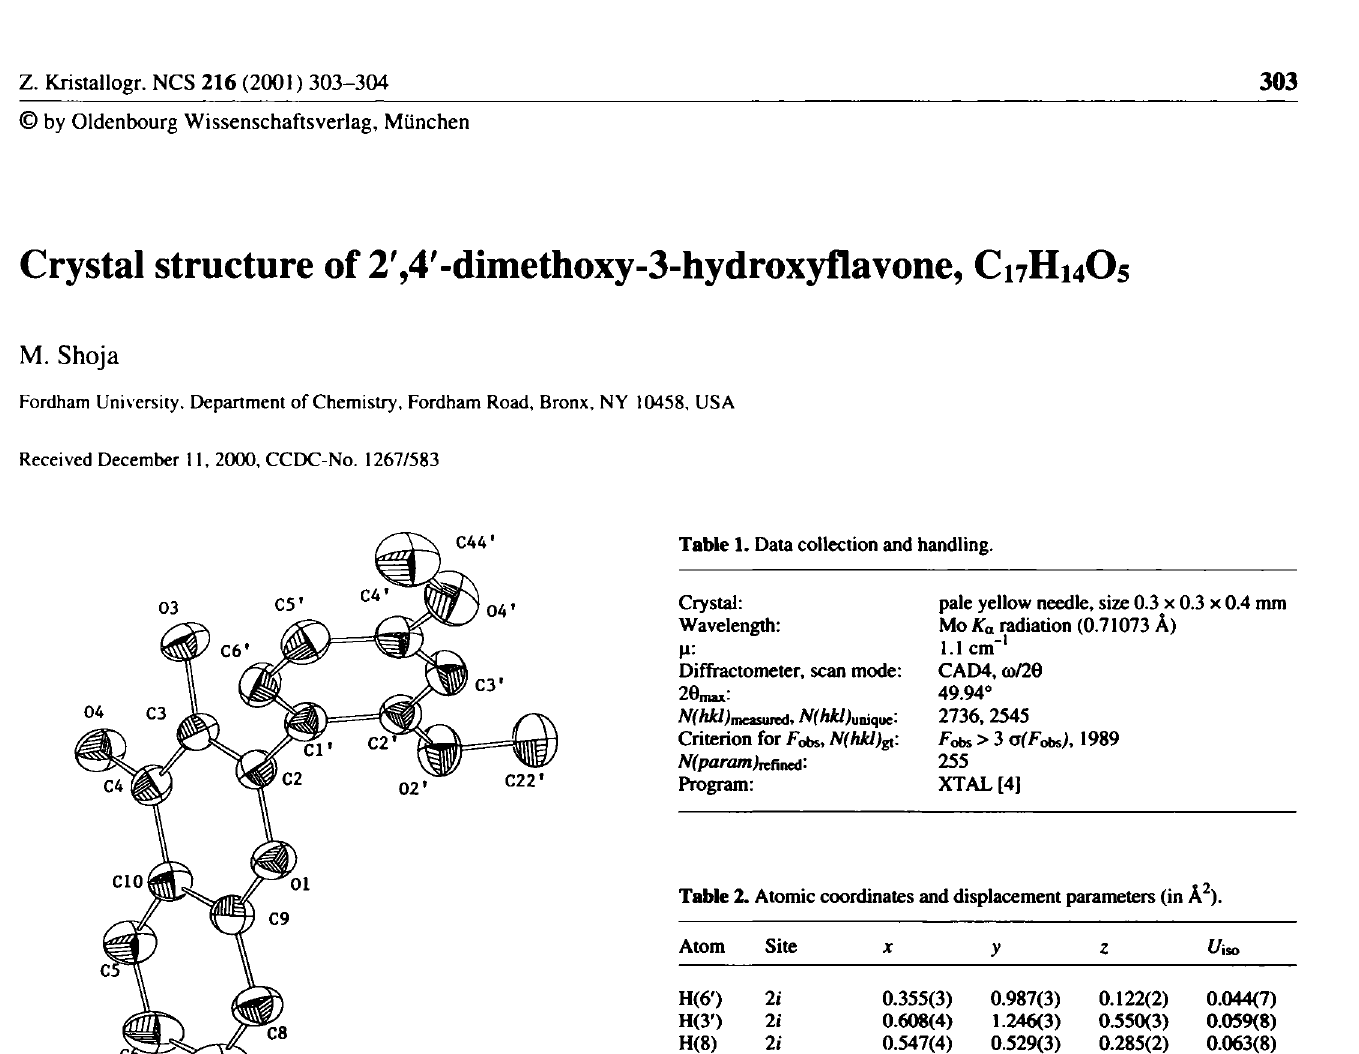
Table 2. Atomic coordinates and displacement parameters (in A 2